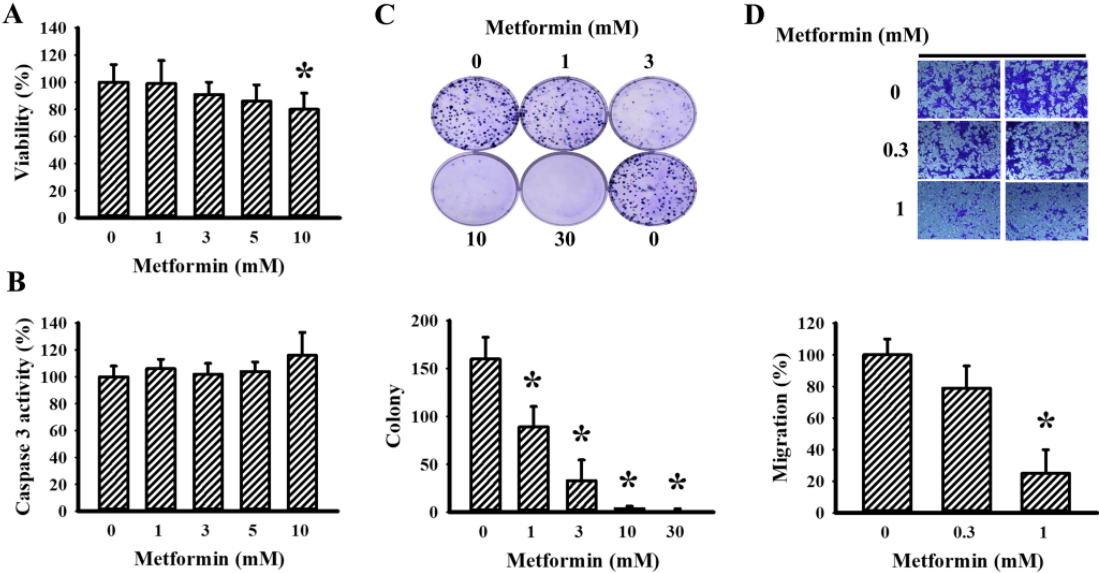
Figure 5. Metformin decreased LLC cell proliferation. Metformin (0–10 mM) was added to the cultured media of LLC cells for 24 h. Cell viability was measured using a CCK-8 kit ( A ) and caspase 3 activity was measured using an enzymatic assay kit ( B ). Metformin (0–30 mM) was added to the cultured media of LLC cells for 6 days. Cell colonies were visualized using crystal violet staining. Representative images and quantitative data are shown ( C ). Metformin (0–1 mM) was added to the cultured media of LLC cells, and cell migration within a course of 24 h was measured using a Transwell-based method. Representative photomicrograph and representative data are shown ( D ). * p < 0.05 vs. metformin (0 mM), n = 4.